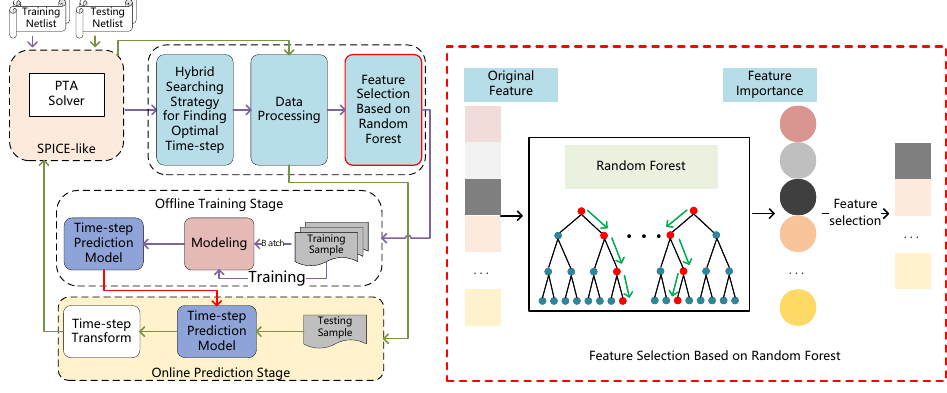
Figure 4. Entire flow of the proposed